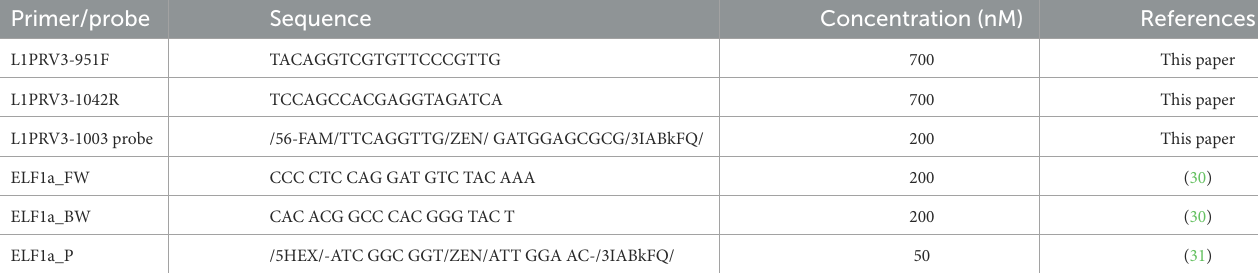
TABLE 2 Sequences and final concentration of primers and probes for PRV-3 detection by RT-qPCR.